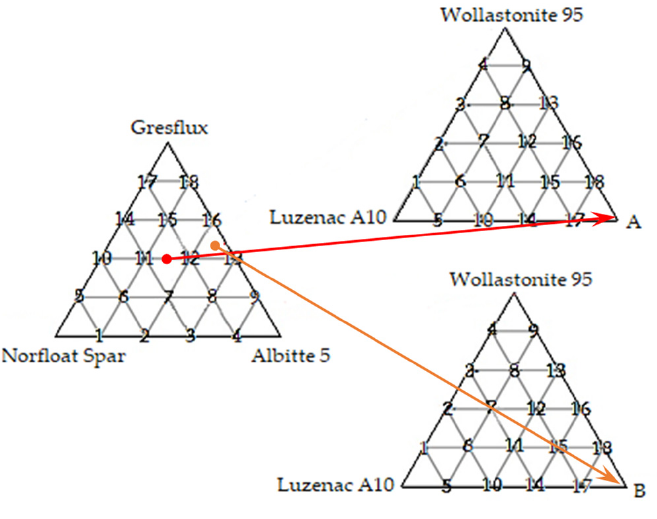
Figure 1. Graphical presentation of the arrangement of mineral fluxes.